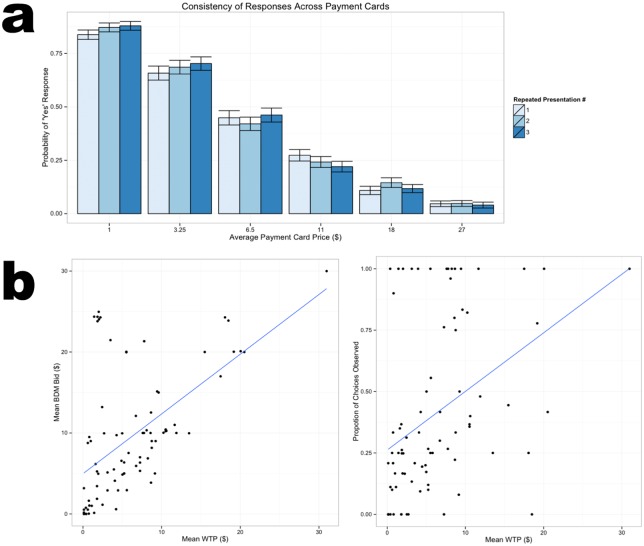
(a) Choice probabilities of subjects for each payment card range did not vary significantly across any and all repetitions that were randomly interleaved across the behavioral session. (b) Correlations between alternative measures of environmental preferences. An extended sample (N = 15) submitted bids and choices in addition to the payment card with the exact same environmental proposals as a measure of consistency. Left: Correlation between mean WTP willingness-to-pay and mean BDM bid for each proposal (r = 0.55, p < 0.01). Right: Correlation between mean willingness-to-pay for each proposal and choices observed (r = 0.39, p < 0.01) between environmental proposals.